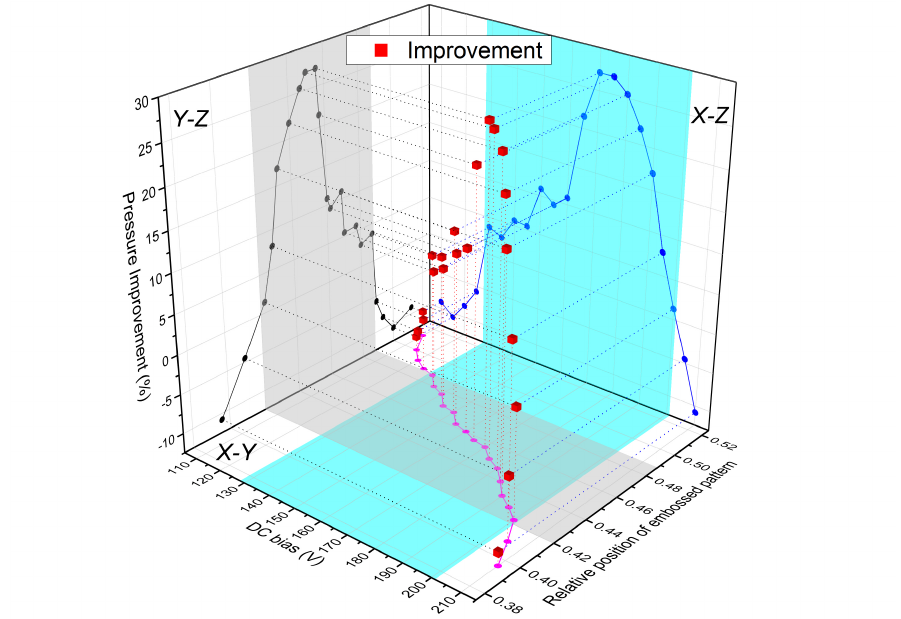
Figure 11. Correlation of DC bias, relative position of the embossed pattern, and pressure